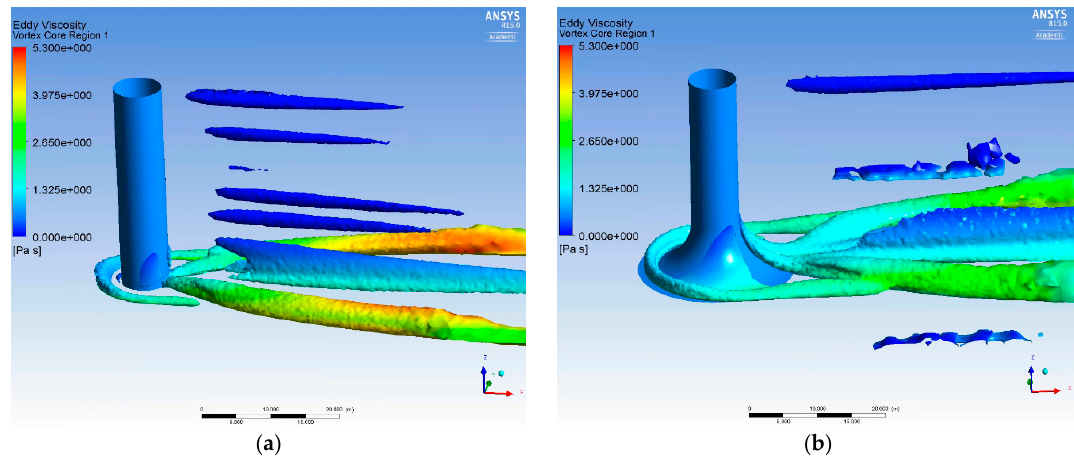
Figure 12. Eddy viscosities: ( a ) before using the SEMCD; ( b ) after using the SEMCD.